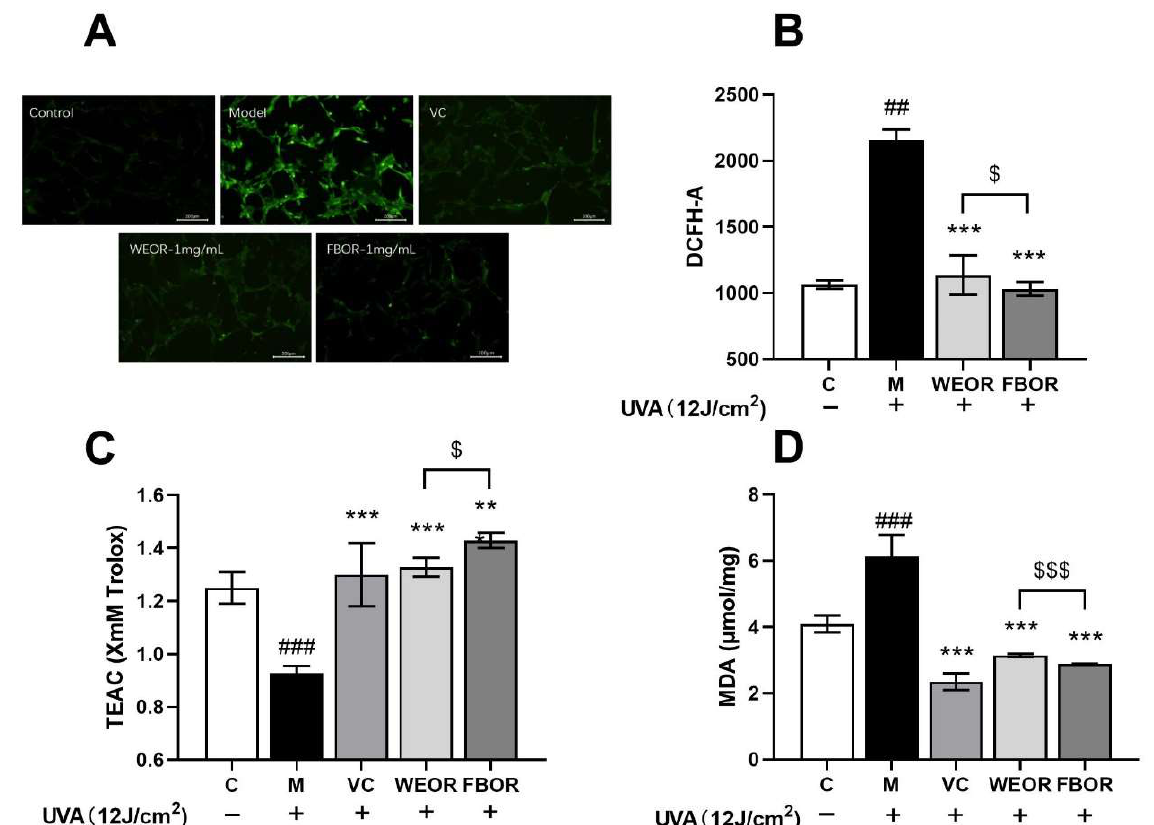
Figure 3. The content of ROS in HDF cells was detected by DCFH-DA staining. ( A ) The photomi- crograph shows (10×) green fluorescence was enhanced in UVA-exposed HDF cells, and WEOR and FBOR pretreatment reduce the content of UVA-induced ROS. ( B ) The graph shows the fluorescence intensity of DCFH-DA in the cell. ( C ) The total antioxidant level in cells (ABTS); ( D ) Intracellular lipid oxidation level. (** p < 0.01, *** p < 0.001, versus the UVB irradiation model group; ## p < 0.01, ### p < 0.001, versus the control group. $ p < 0.05, $$$ p < 0.001, the WEOR group versus the FBOR group. C: Control group; M: UVB irradiation model group).